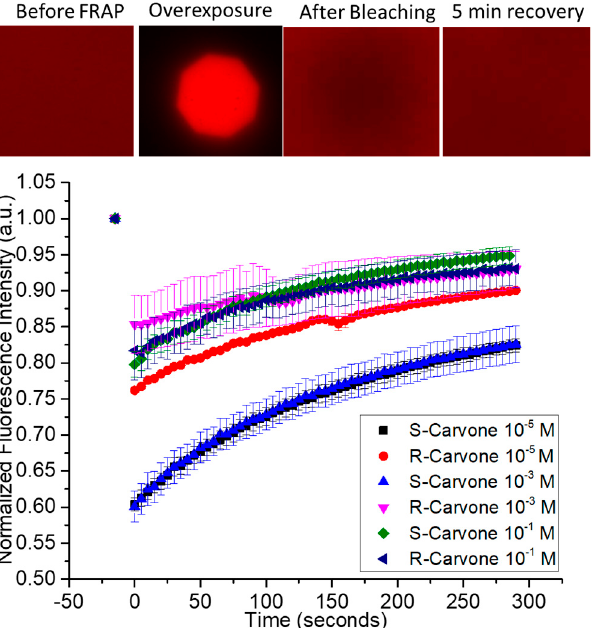
Figure 2. Fluorescence recovery after photobleaching of supported lipid bilayers upon exposure to enantiomeric odorants S-carvone and R-carvone. Top—examples of data from the FRAP experiment. A fluorescently labeled supported lipid bilayer was exposed to high-intensity light through an aperture to bleach a circular area within the spot. The fluorescence intensity of the bleached spot was measured as lipids diffused into it from the unbleached region. Represented are FRAP data from the two enantiomers, measured at 3 different concentrations.